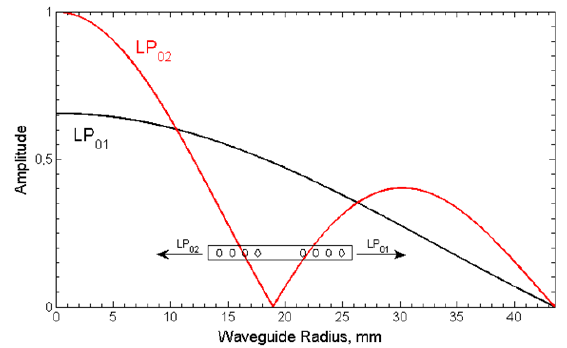
Figure 14. Absolute amplitude of the LP 01 and LP 02 mode show- ing the possibility of mode sensitive coupling in opposite direc- tions inside the fundamental mode waveguide.